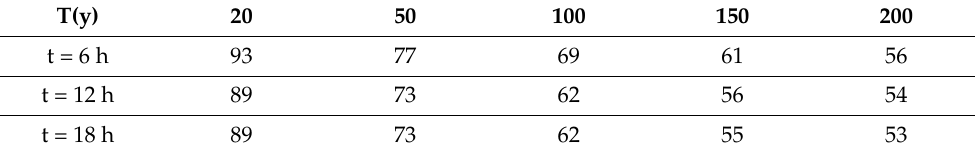
Table 5. Reduction in the inundation area (%) because of the flood protection